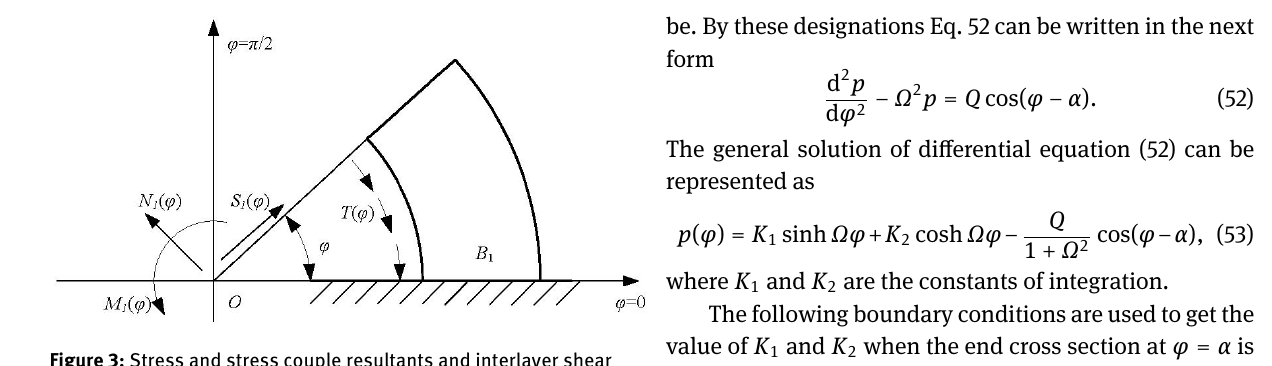
Figure 3: Stress and stress couple resultants and interlayer shear force on beam component